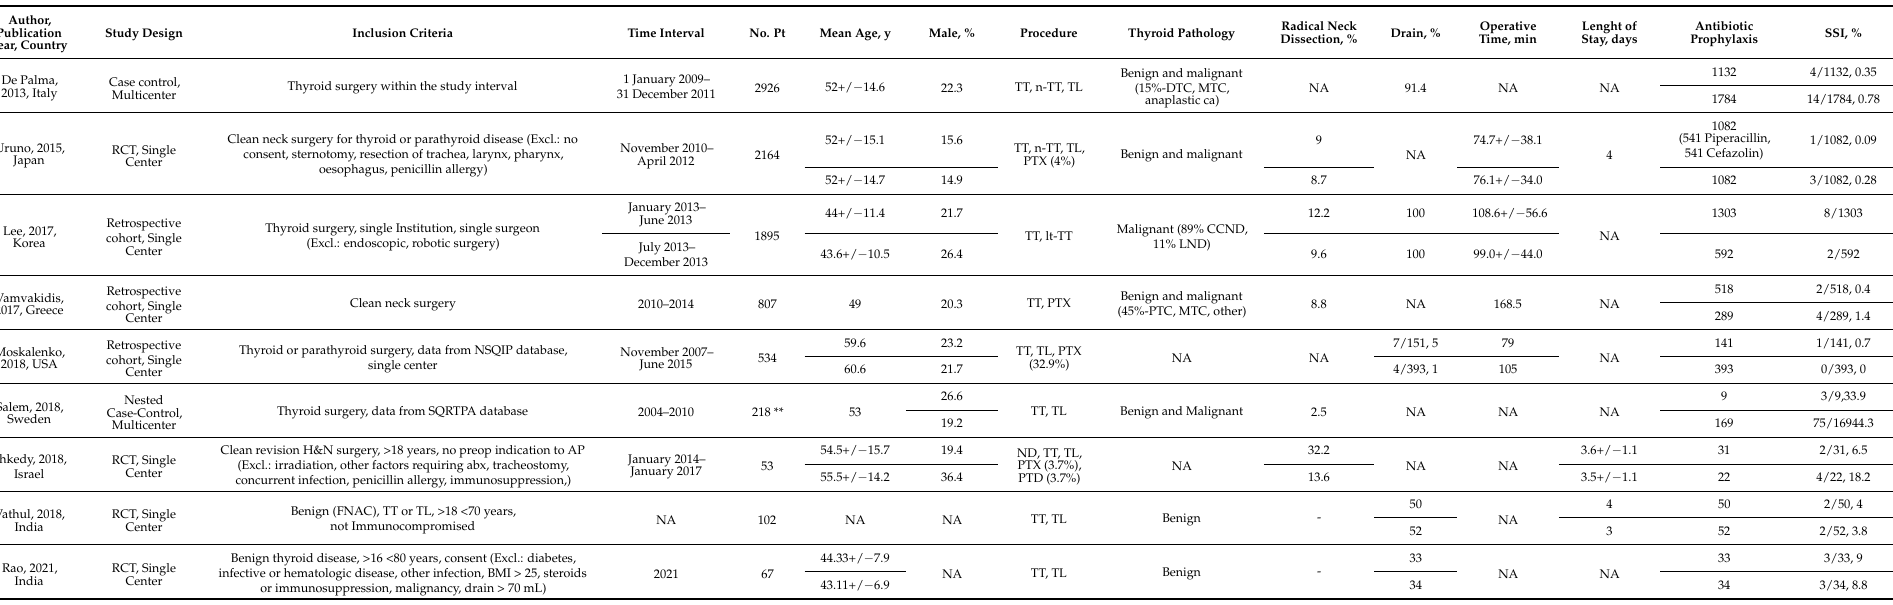
Table 1. Study design, characteristics of populations, interventions and outcomes in the included